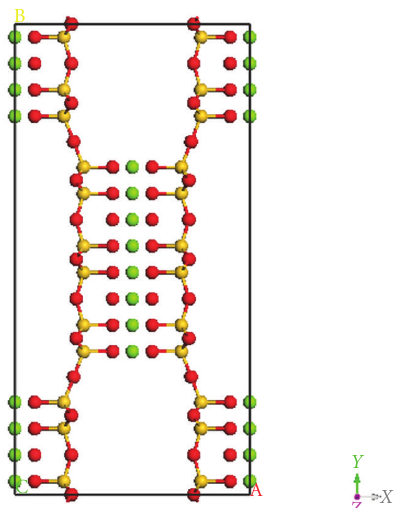
Figure 2: Unit cell of sepiolite, showing magnesium (green) octahe- drally coordinated between chains of SiO 4 (silicon shown in orange, oxygen in white). View is along the c -axis.